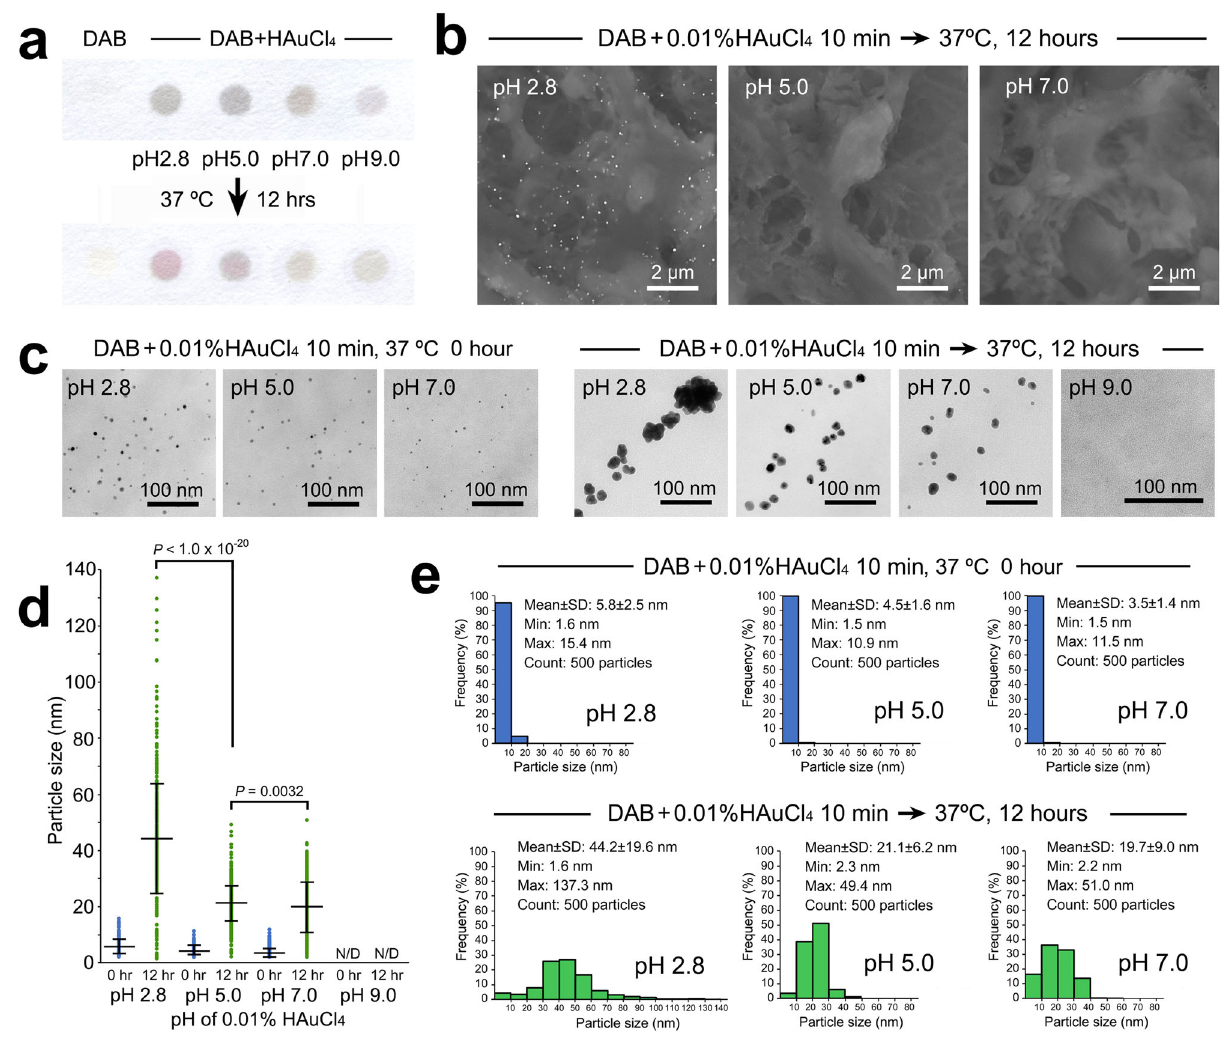
Fig. 7 In fl uence of pH on nanogold size. a Primary screening by fi lter paper model assay. Note the decline in the purplish tone in proportion to